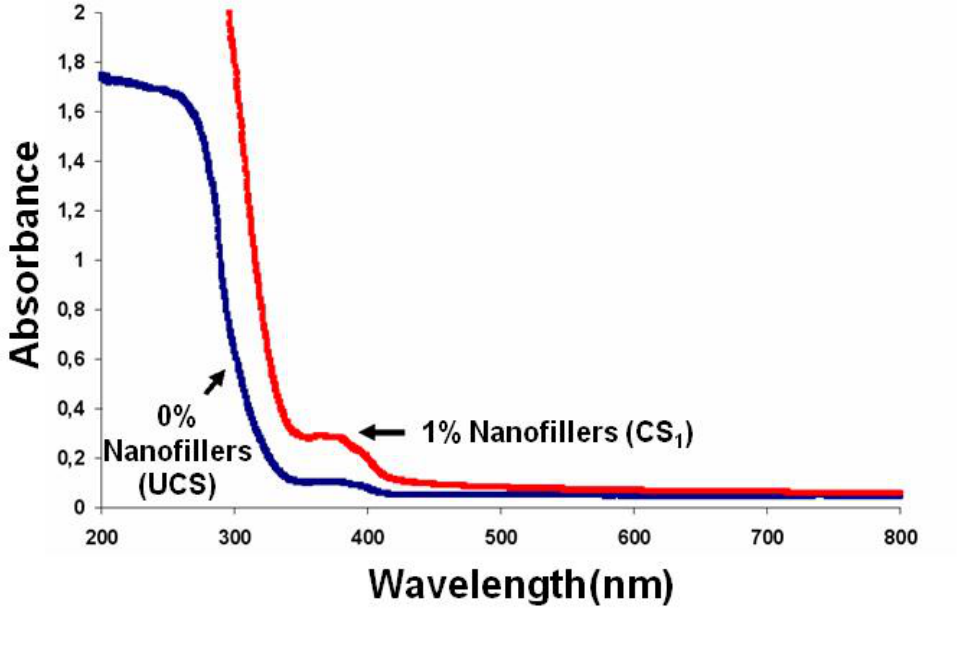
Figure 9. TEM micrographs of CS